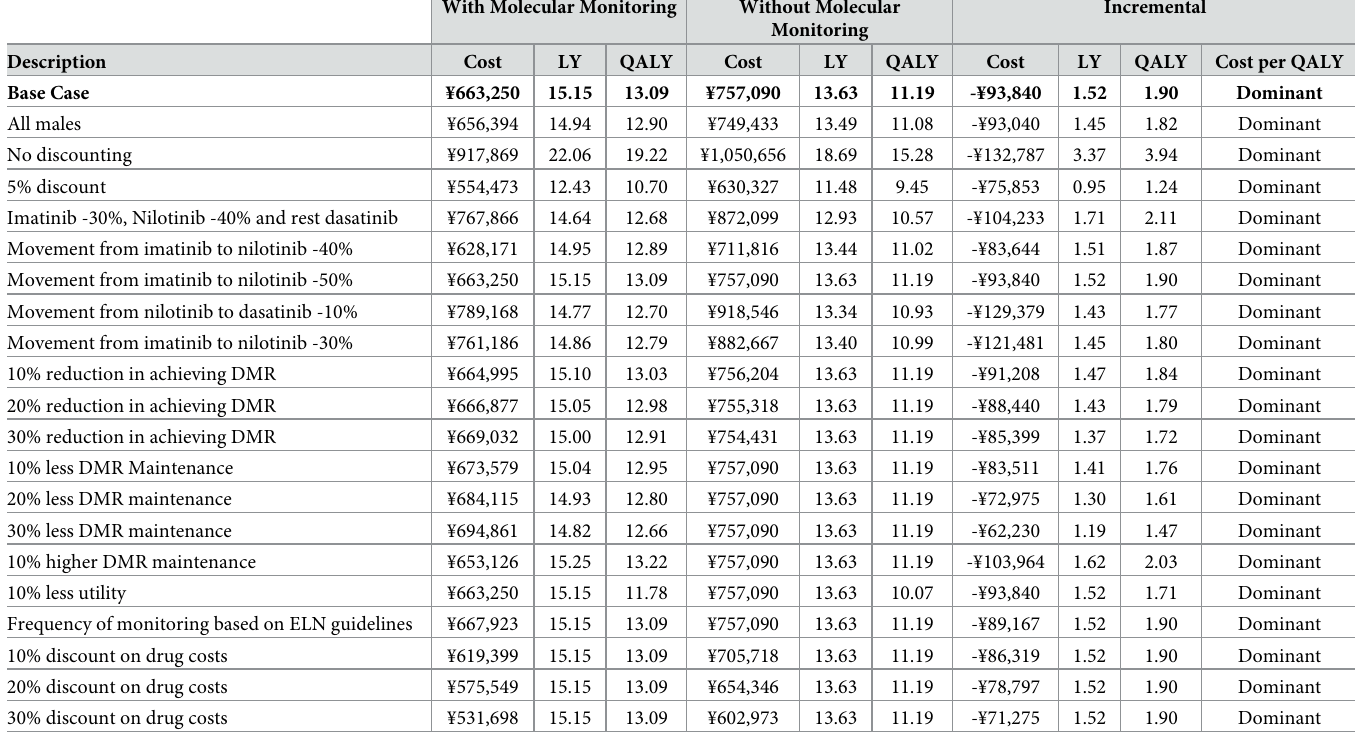
Table 5. Scenario analysis